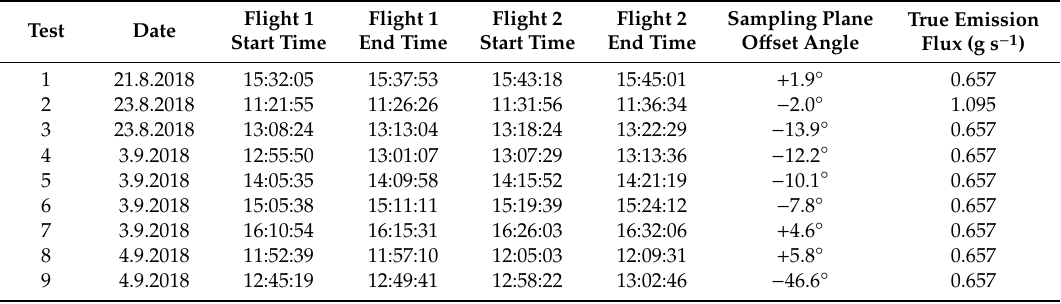
Table 1. UAV flight times (in Greenwich Mean Time) for each test with corresponding emission flux